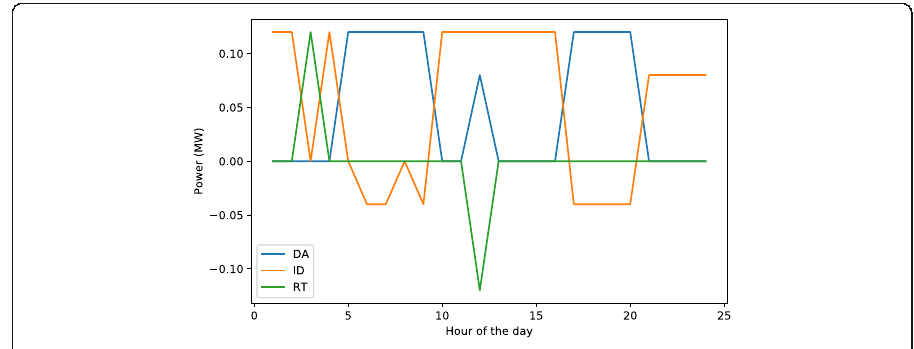
Fig. 4 Optimal bidding schedule based on linear program